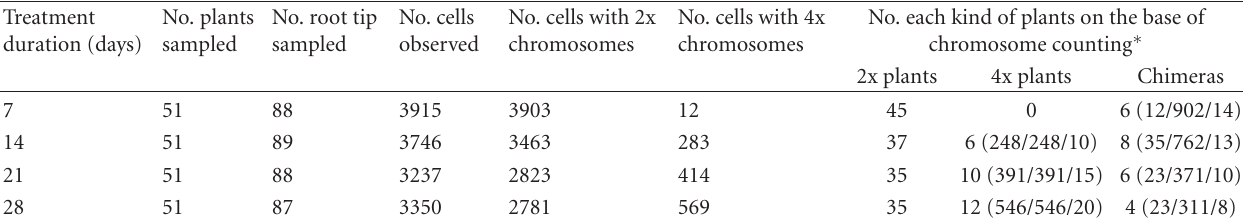
Table 4: Comparison of the e ff ect of colchicine treatment duration on chromosome doubling of regenerated plants. Treatment